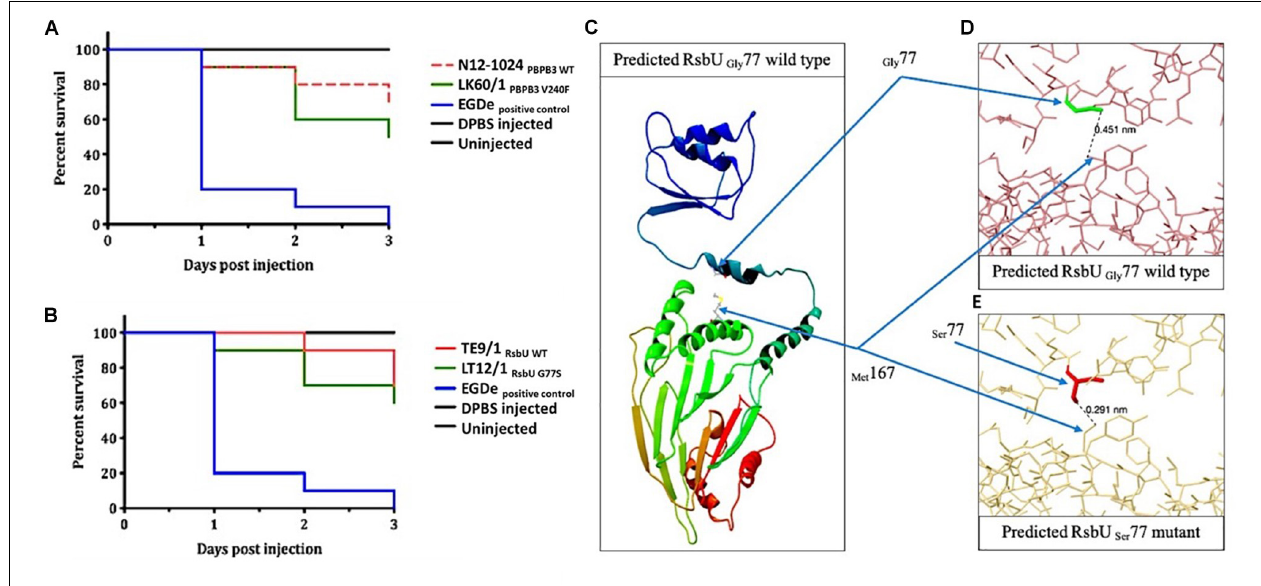
FIGURE 7 | Virulence evaluation of the high nisin resistance L. monocytogenes field strains harbouring the PBPB3 V240F and RsbU G77S mutations and theoretical structural modeling prediction analysis of the RsbU G77S mutant protein. Kaplan–Meier plots depicting the survival trends of zebrafish embryos ( n = 30 per L. monocytogenes strain) infected (100 CFU per embryo) with the high nisin resistance mutant strains (A) LK60/1 (PBPB3 V240F ; CC121) and (B) LT12/1 (RsbU G77S ; CC7) and their respective clonal control strains, N12-1024 (CC121) and TE9/1 (CC7), without mutation. Data are based on three independent biological experiments. Survival rate and trends at 48 and 72 h post infection were significantly lower in LK60/1 (PBPB3 V240F ) and LT12/1 (RsbU G77S ) infected zebrafish embryos infected compared to their respective control strains N12-1024 and TE9/1 ( P < 0.05). (C) Gly 77 and Met 167 in wild type RsbU as predicted in Phyre2. (D) RsbU Gly 77 wild type showing the distance (nm = 0.451) between Gly 77 and Met 167 as predicted by Missense3D. (E) Missense3D-predicted RsbU Ser 77 mutant showing the distance (nm = 0.291) between Ser 77 and Met 167 , and the possible cause for 85.5 Åˆ3 collapse in cavity volume after G77S substitution. The figures were generated in (C) CLC Genomics Workbench and (D,E) Missense3D online